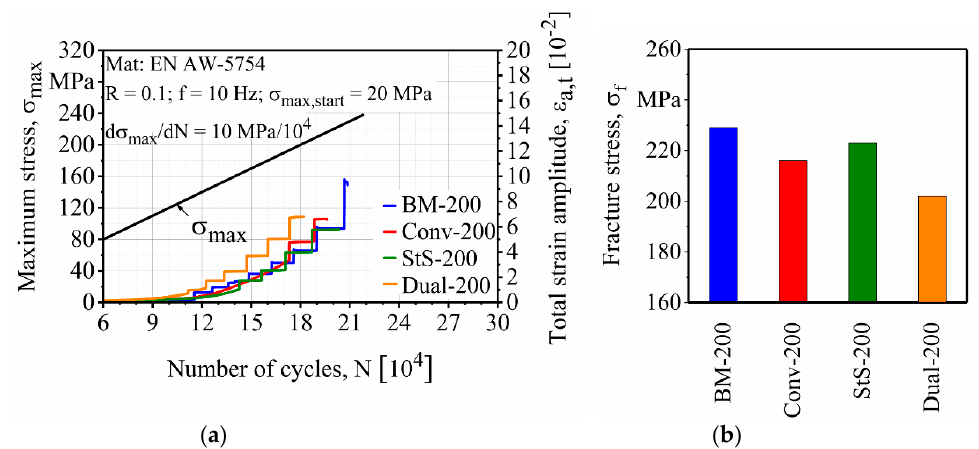
Figure 19. Effect of the cyclic climate change test on the ( a ) load increase test and ( b ) fracture stresses of base and friction stir welded (FSW) EN AW-5754 specimens.